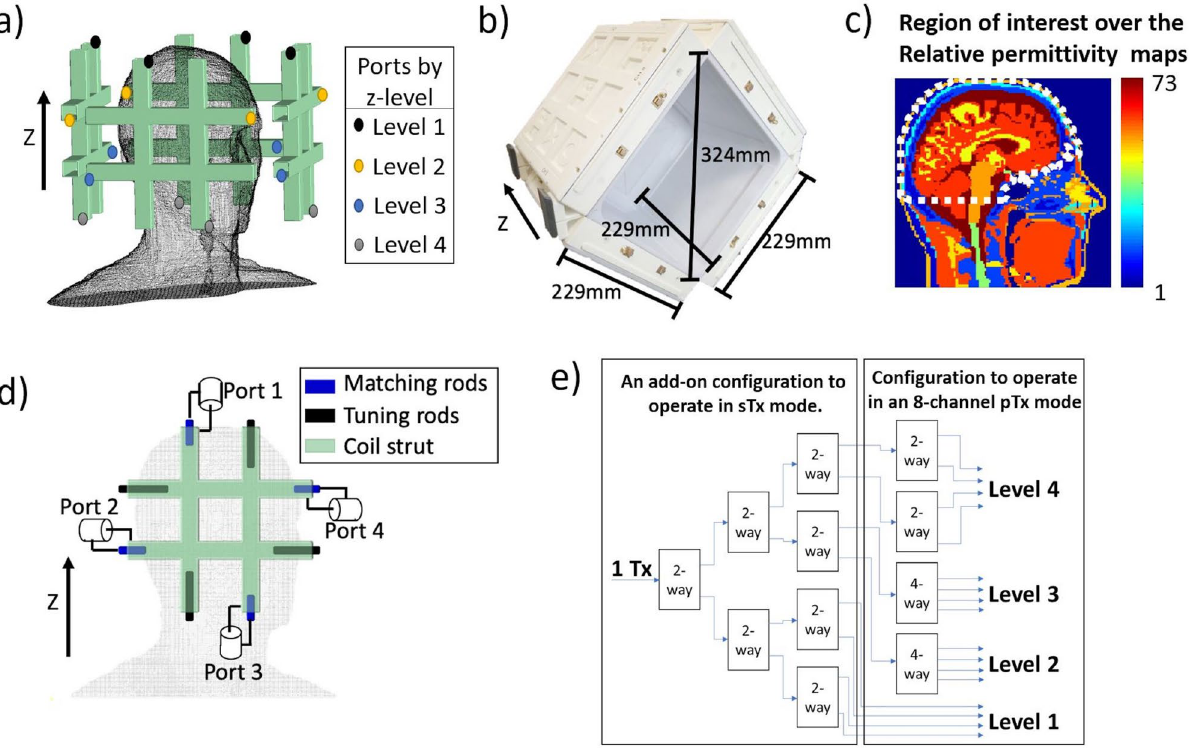
Figure 1. The 16-channel Tic Tac Toe (TTT) Tx head coil FDTD model and experimental implementation. In ( a ), the coil geometry with the locations of the 16 channels of the transmit head coil, which are divided into 4 levels in Z-direction; In ( b ), the assembled 16-channel TTT Tx coil and its dimensions; In ( c ), the region of interest (white dashed line) plotted over the relative permittivity map of the Duke model at ~ 297.2 MHz (7 T proton frequency). In ( d ), the ports, matching rods, and tuning rods of a representative panel of the coil. In ( e ), the RF power splitting configuration—exclusively using 2-way and 4-way Wilkinson power dividers—to drive the 16-channel transmit coil using the system’s sTx or pTx modes. The Tx channels associated with the coil’s levels 1, 2, 3, and 4 (shown in ( a )) experience normalized voltage amplitudes equal to 1, 0.5, 0.5, and 1/√2,